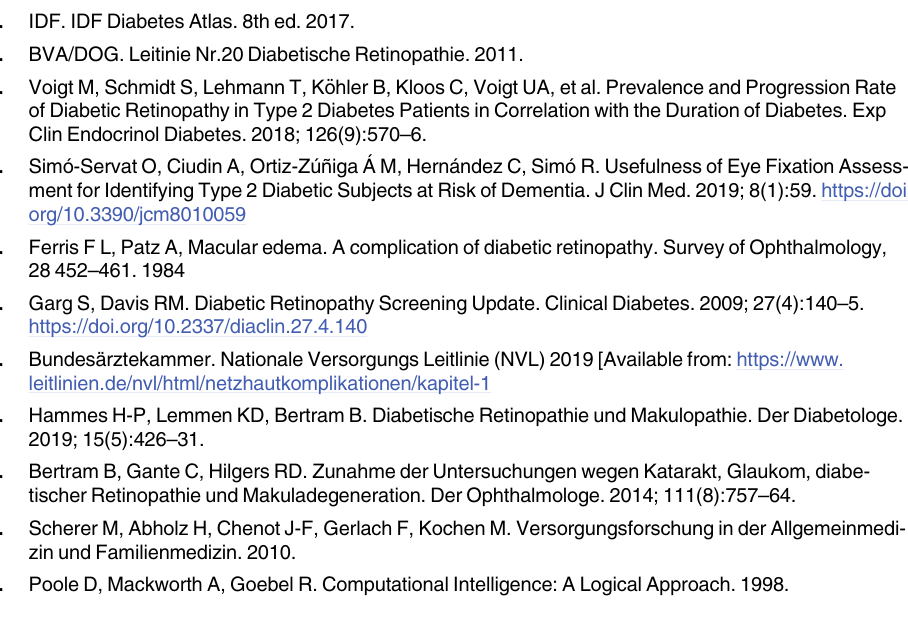
S1 Table. Data extraction table. S2 Table.